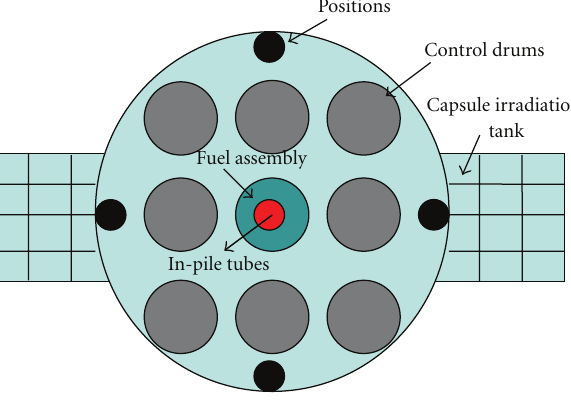
Figure 2: The irradiation locations of ATR core